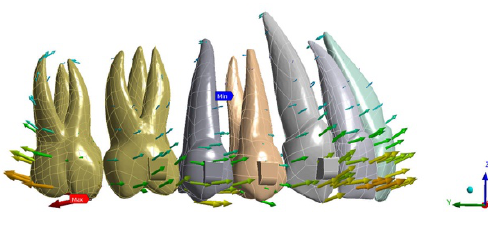
Figure 2. ATT 3–6 tooth displacement.